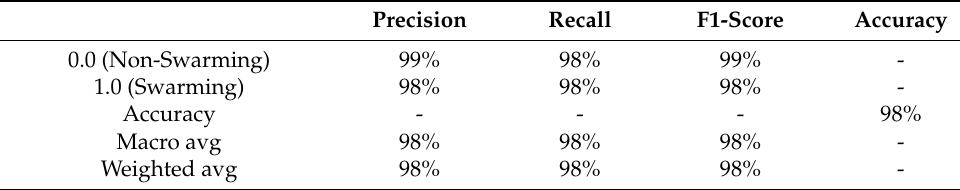
Table 9. k-NN Classifier results applied 5 days before the swarming event. Precision Recall